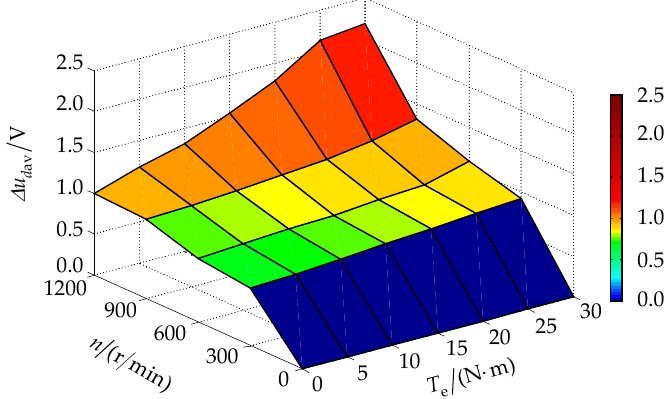
Figure 13. The variation diagram of ∆ u d av with the electromagnetic torque and the speed.